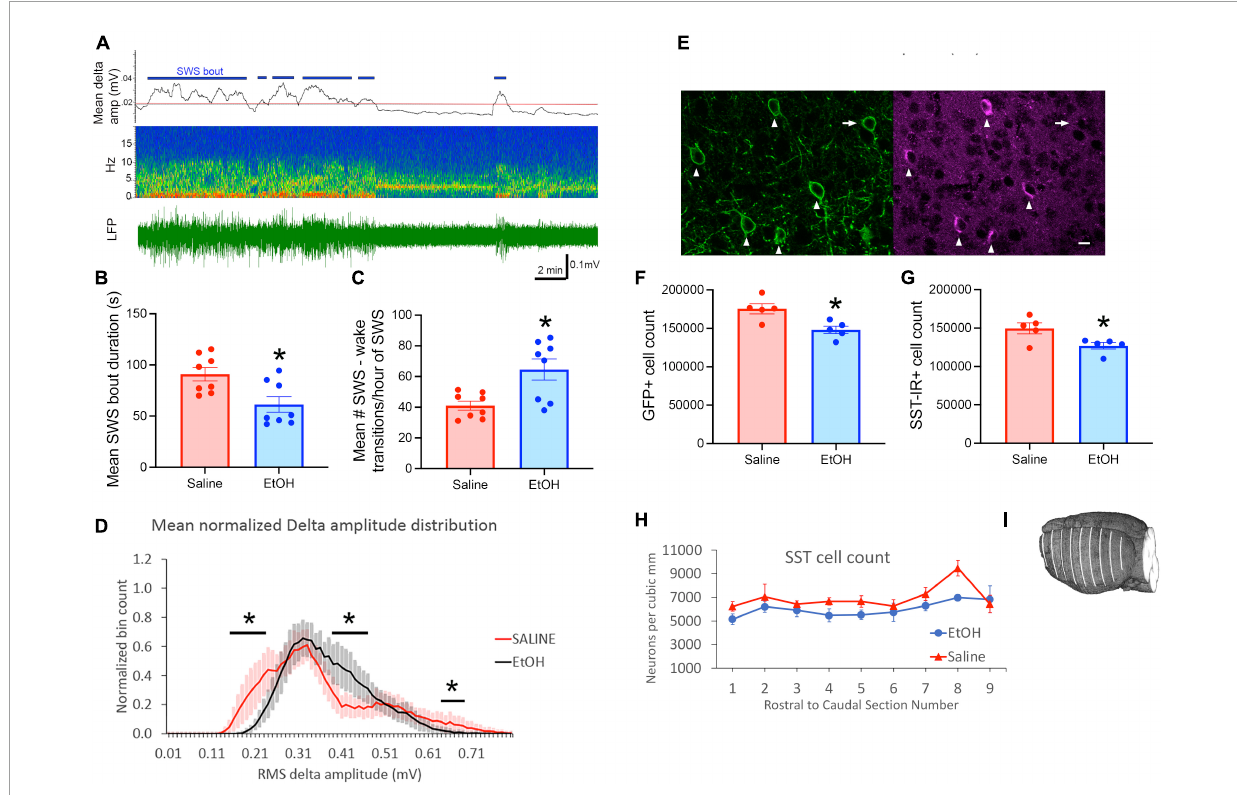
FIGURE1 Slow-wave sleep in adult SST cre × Ai32 mice exposed to ethanol at P7 was impaired compared to saline controls. (A) Representative cortical LFP recording with raw LFP shown in bottom trace and time-frequency pseudocolor spectrograph shown in center. Top trace shows r.m.s. delta amplitude and 1 standard deviation above mean delta amplitude (red line) extracted from a 24 h recording. Periods of delta amplitude above the red line were classified as slow-wave sleep (horizontal blue markers) and coincided with behavioral inactivity as previously described (Wilson et al., 2016; Lewin et al., 2018). Slow-wave changes in ethanol mice compared to saline ( n = 8/group) included (B) shorter SWS bout durations and (C) increased sleep-wake transitions, which together constitute sleep fragmentation. (D) In addition, delta amplitude oscillations were modified to display significantly fewer high amplitude waves. Horizontal lines highlight regions of significant post hoc comparisons between treatment groups ( p < 0.05). (E) Stereological cell counts were used to evaluate the number of somatostatin cells in neocortex, in sections double labeled with ant-GFP and anti-somatostatin antibodies ( n = 5 mice/group). In 85% of the SST-Cre cells, SST-immunolabeling (arrowheads) was found, but it was not confirmed in the remaining cells (arrow). We did not find SST-immunolabeled cells that lacked SST-Cre. Scale bar = 10 um. (F,G) P7 Ethanol exposure significantly reduced SST cell count as assessed in both GFP cells and SST immunolabeled cells. (H) Separation of stereological cell counts by anterior-posterior location indicated that the ethanol-induced reduction of SST cells is similar throughout the neocortex. Measured neuron densities were separated by their rostral-caudal section number. In brains that had more than 9 sections, the final small end sections were combined. This line graph provides a qualitative overview of local differences, as the stereological strategy was designed to sample the whole cortex, and data from each section includes an average of only 24 sampling sites from each brain. (I) The location of the neocortex (white lines) that was sampled for stereological estimates of SST neuron number and density is shown on a reconstruction of one brain made from block-face images taken during sectioning. Every 12th 50 uM thick coronal section through the neocortex was sampled. Asterisks signify significant difference between ethanol and saline conditions in all